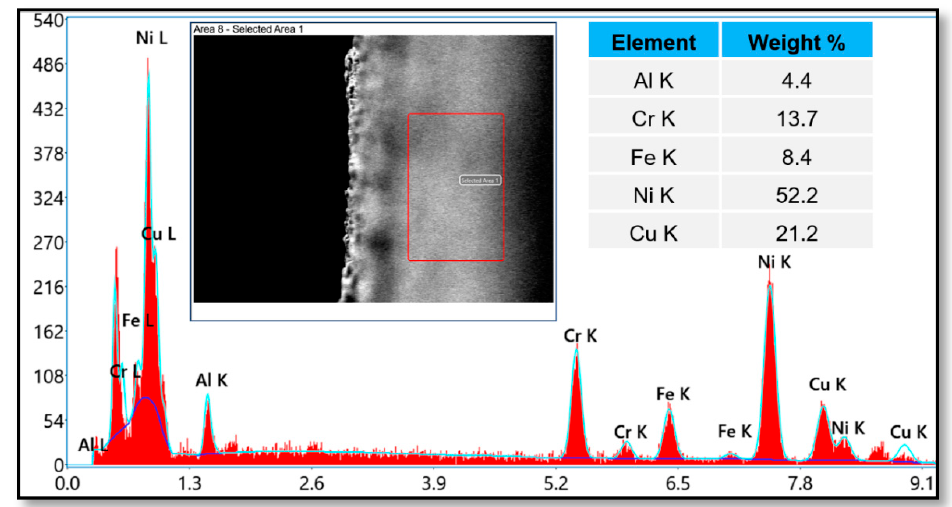
Figure 2. SEM and EDS of an Inconel 600 specimen before machining.